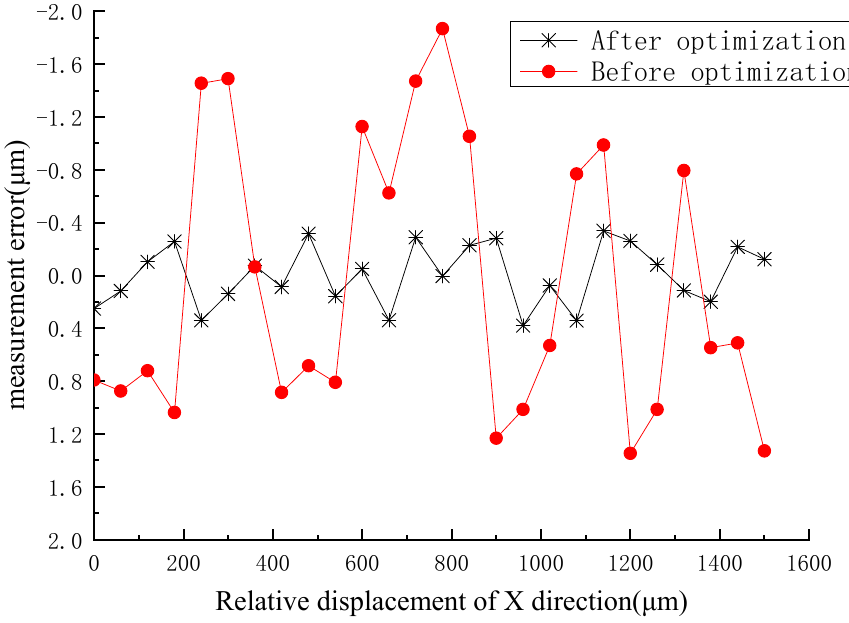
Figure 10. Comparison experiments in X direction.